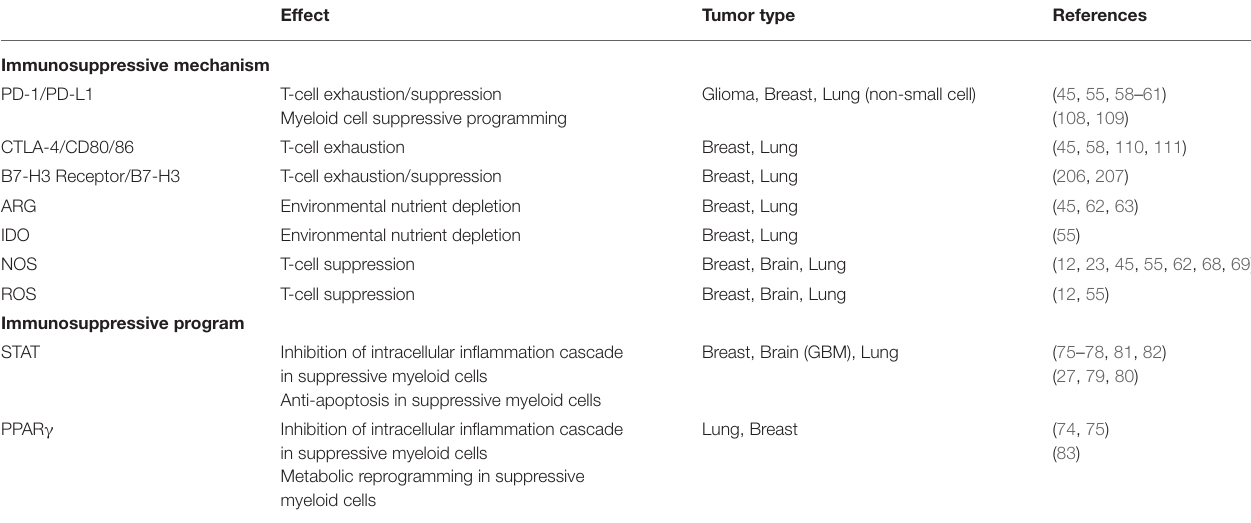
TABLE 1 | Immunosuppressive mechanisms employed by MDSCs and TAMs, as well as stereotypic programming that regulate the mechanisms. Effect Tumor